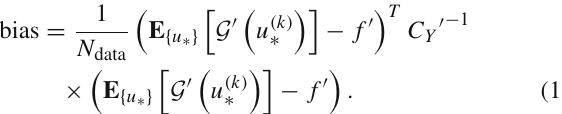
Fig. 3 Example of geometric interpretation of closure test estimators. The origin is the true observable values for each data point. The level one data (or experimental central values) are shifted away from this by η . In this example the covariance matrix is diagonal, so the eigenvectors correspond to the two data points, the square root of the eigenvalues are simply the standard deviation of those points. This is without loss of generality because any multivariate distribution can be rotated into a basis which diagonalises the covariance matrix. The 1-sigma observa- tional noise confidence interval is a unit circle centered on the origin. Some closure estimators can be understood as l2-norms of the vectors connecting points, i.e the bias is the l2-norm of the vector from the origin to the central value of the